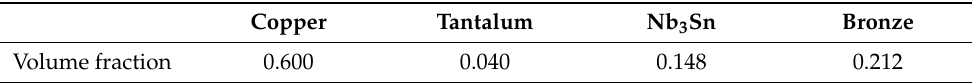
Table 1. Volume fractions of each component material of EAS-Nb 3 Sn strand. Copper Tantalum Nb 3 Sn Bronze Volume fraction 0.600 0.040 0.148